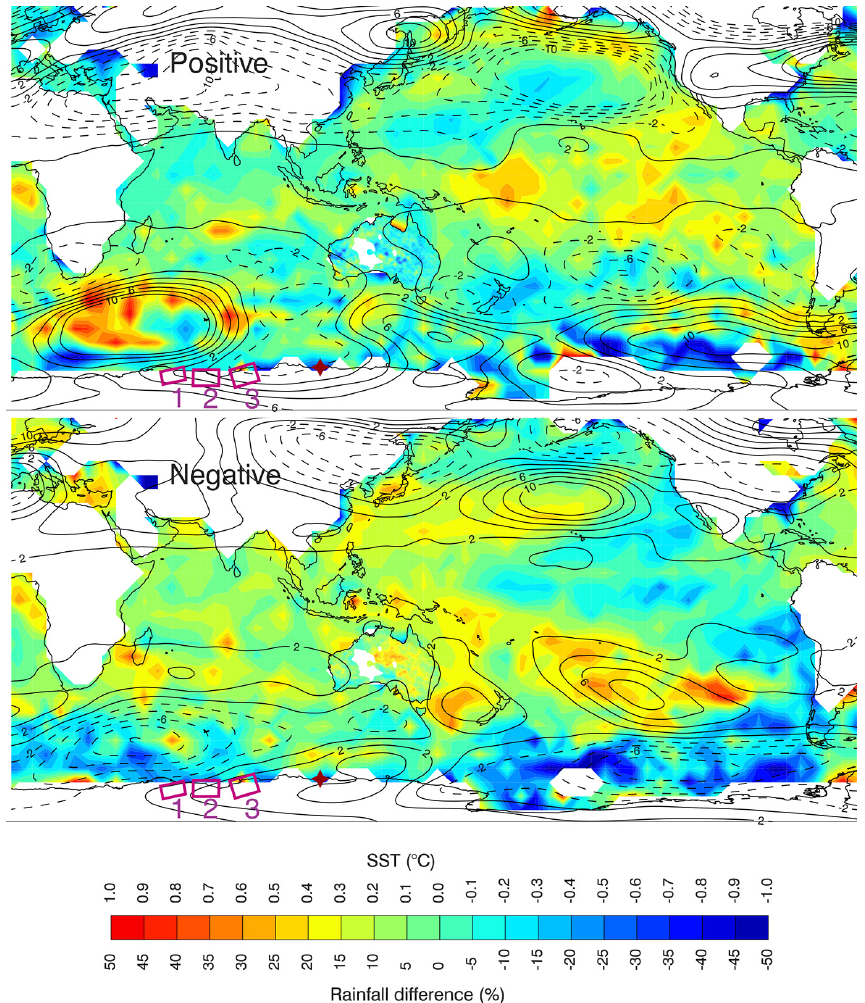
Figure 6. Sea surface temperature, 500m geopotential height and Australian rainfall correlation analysis with IPO during the warm season (November–March) for positive (top) and negative (bottom) years. For this analysis we used ERA-20C over 1960–2010, defining positive and negative years as 0.5 SD above or below the average respectively. See the Supplement for this analysis performed using ERA-Interim over 1979–2014. Note that the colour bar defines a rainfall increase over Australia, as well as warm SSTs, as the red spectrum (conversely, a rainfall decrease and cool SSTs are blue). Identified in fuchsia are regions shown in previous figures: 1 – Law Promontory and